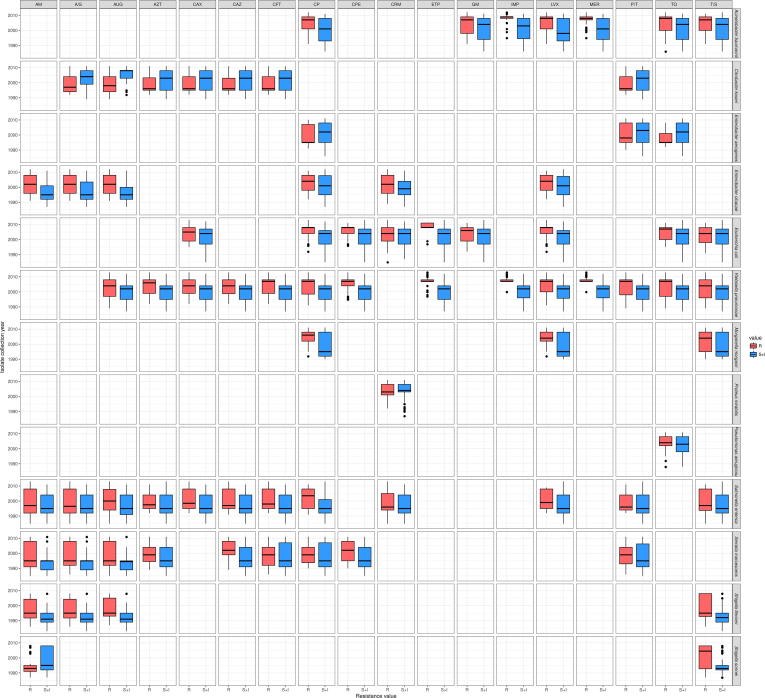
Boxplots of the temporal distribution of non-resistant and resistant isolates Boxplots of collection year for the non-resistant (blue) and resistant (red) isolates for all species–drug combinations with a significant result (adjusted P < 0.01). Only isolates and drugs used for comparison using the two-sided WMW test are shown.